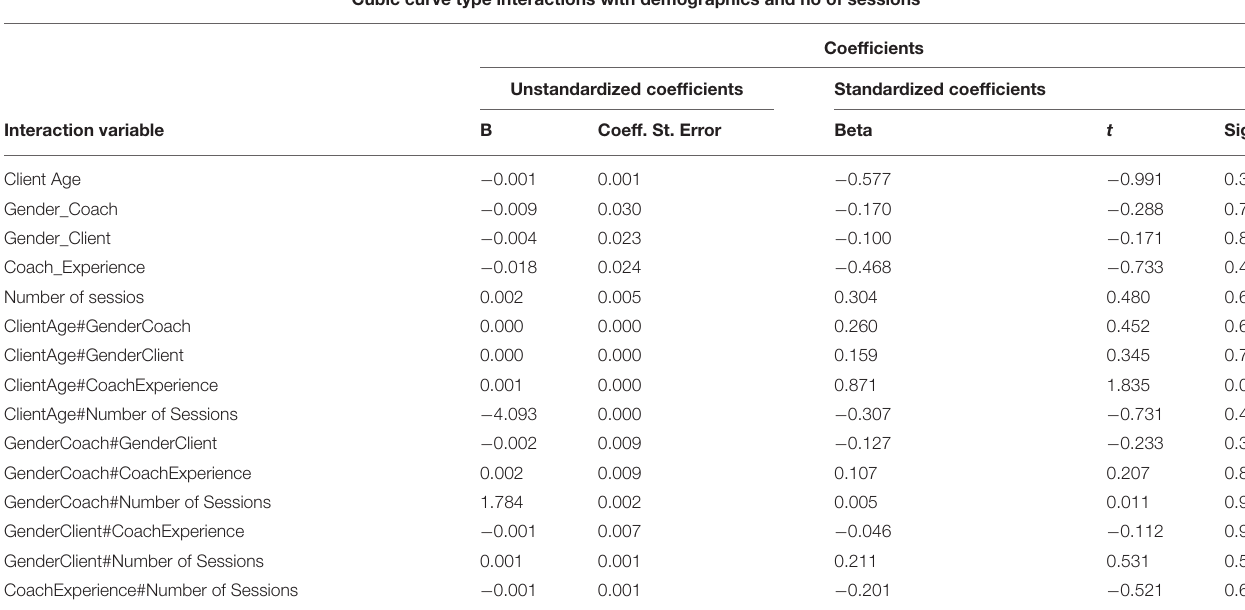
TABLE 5c | Cubic curve type interactions. Cubic curve type interactions with demographics and no of